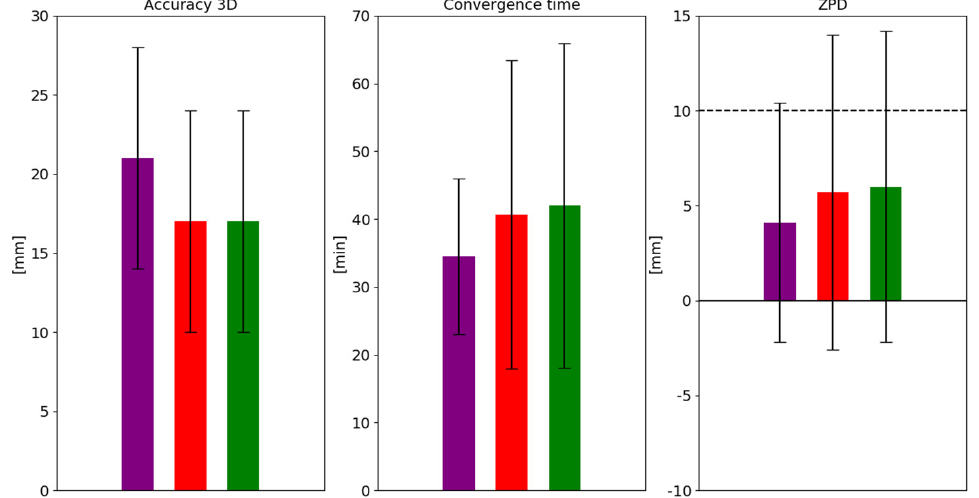
Figure 11. Mean accuracy 3D ( left ), convergence time ( center ) and ZPD ( right ) from all stations and all periods for the proposed weighting method—GE_new (purple), GE (red) and GE1 (green) for Function 2.